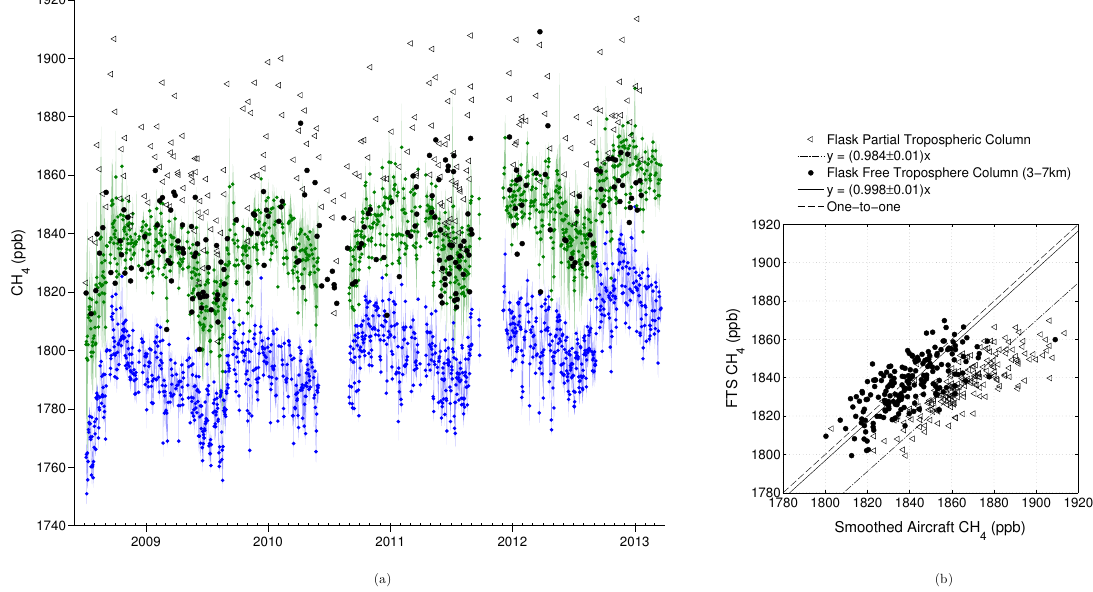
Figure 9. (a) Daily median column and aircraft CH 4 DMFs at Lamont. Flask partial tropospheric columns integrate CH 4 from the minimum to the maximum altitudes of the aircraft measurement. Flask free troposphere columns integrate CH 4 from the minimum to the maximum altitudes of the aircraft within 3–7km. Total and tropospheric column DMFs are the same as in Fig. 4. (b) Tropospheric CH 4 column comparison for TCCON vs. in situ profiles.